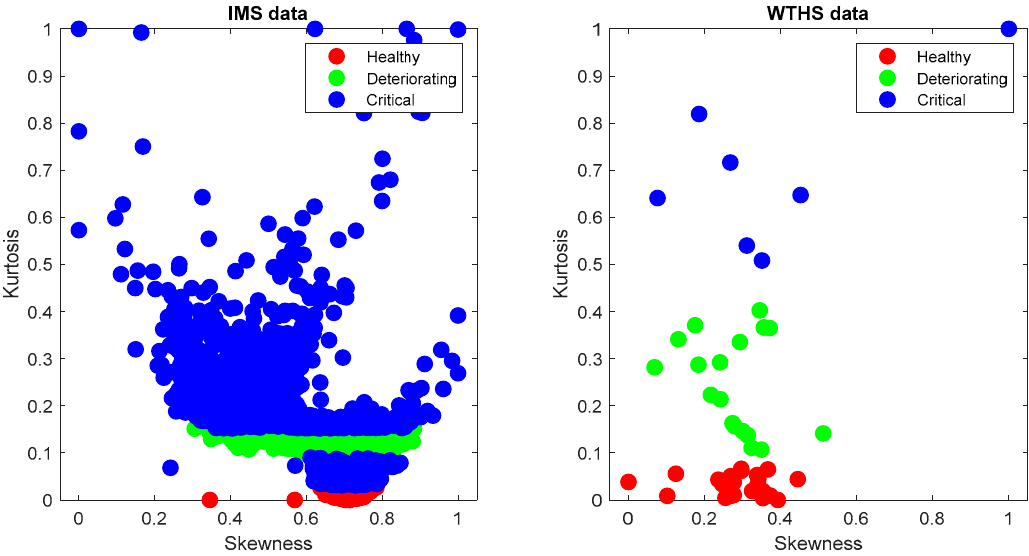
Figure 8. Results of health stage (HS) splitting by Gaussian mixture model (GMM).